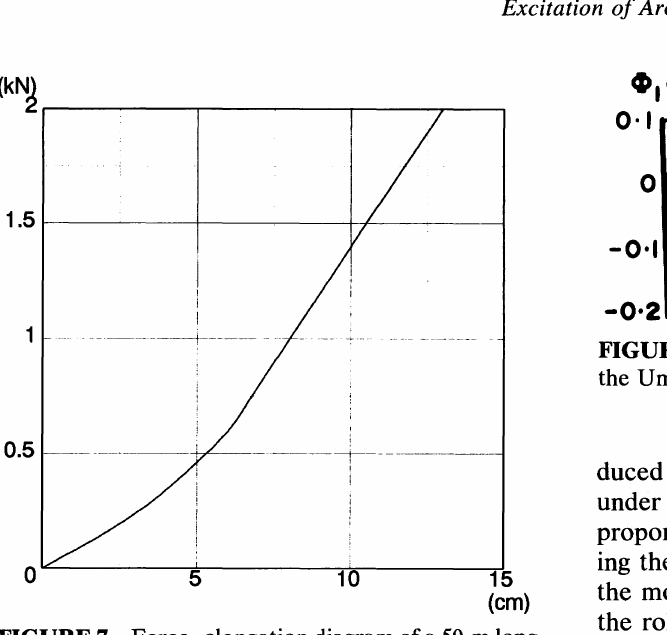
FIGURE 7 Force-elongation diagram of a 50-m long subwire.